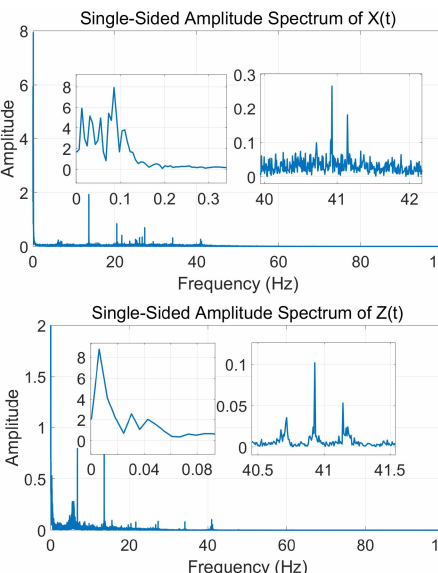
Figure 9. Spectrum analysis of the reconstructed signal after the MEEMD filtering of the three axis acceleration signal.